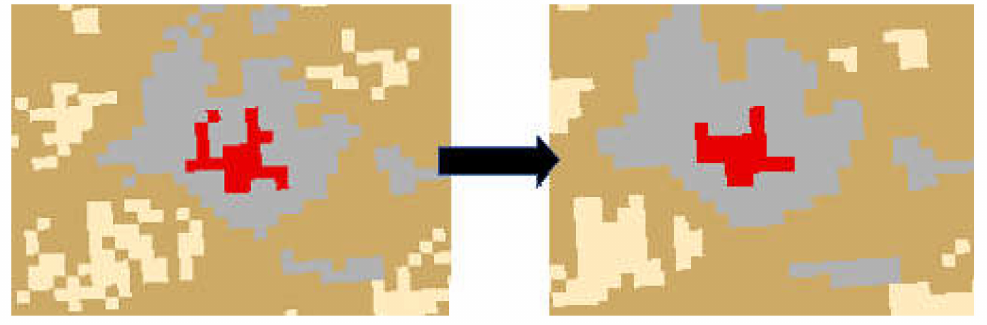
Figure 3. Example of majority filter in the study area.